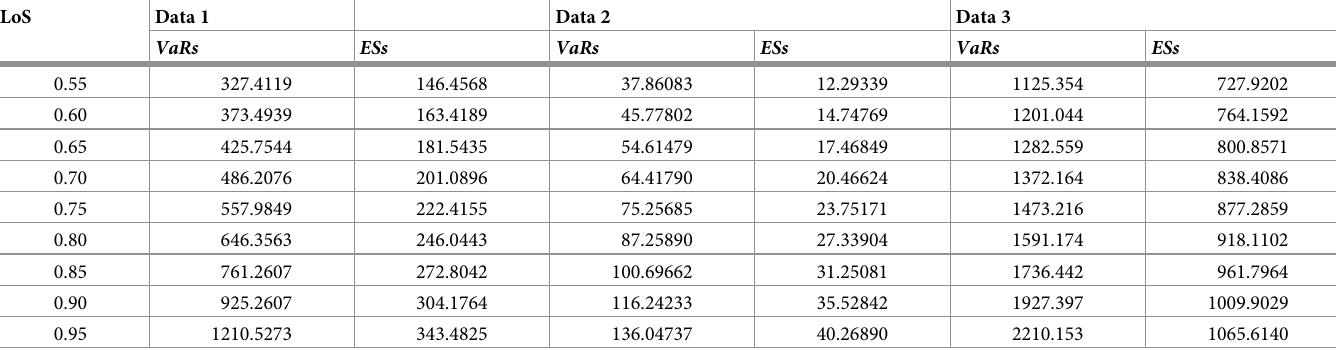
Table 12. Numerical measures of VaRs and ESs of EGuNH for D1, D2 and D3. LoS